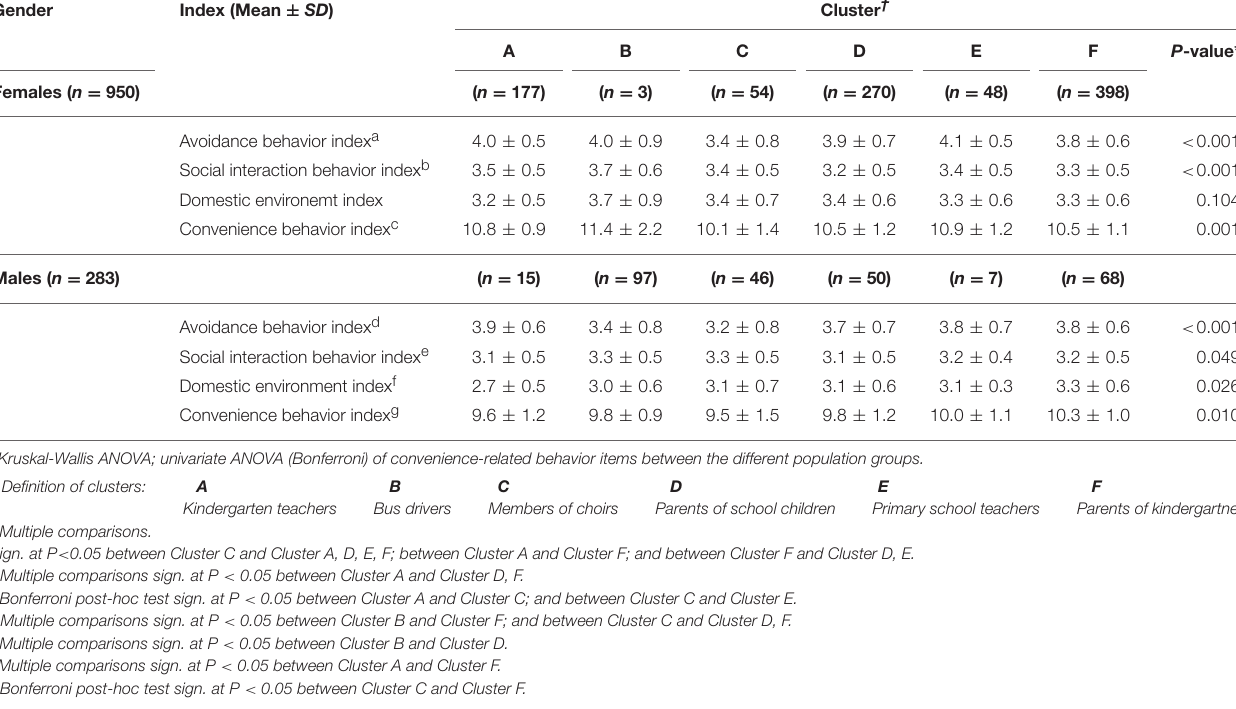
TABLE 4 | Descriptive characteristics of convenience-related items between different clusters † in males and females ( n = 1233). Gender Index (Mean ± SD ) Cluster † A B C D E F P -value* Females ( n = 950) ( n = 177) ( n = 3) ( n =